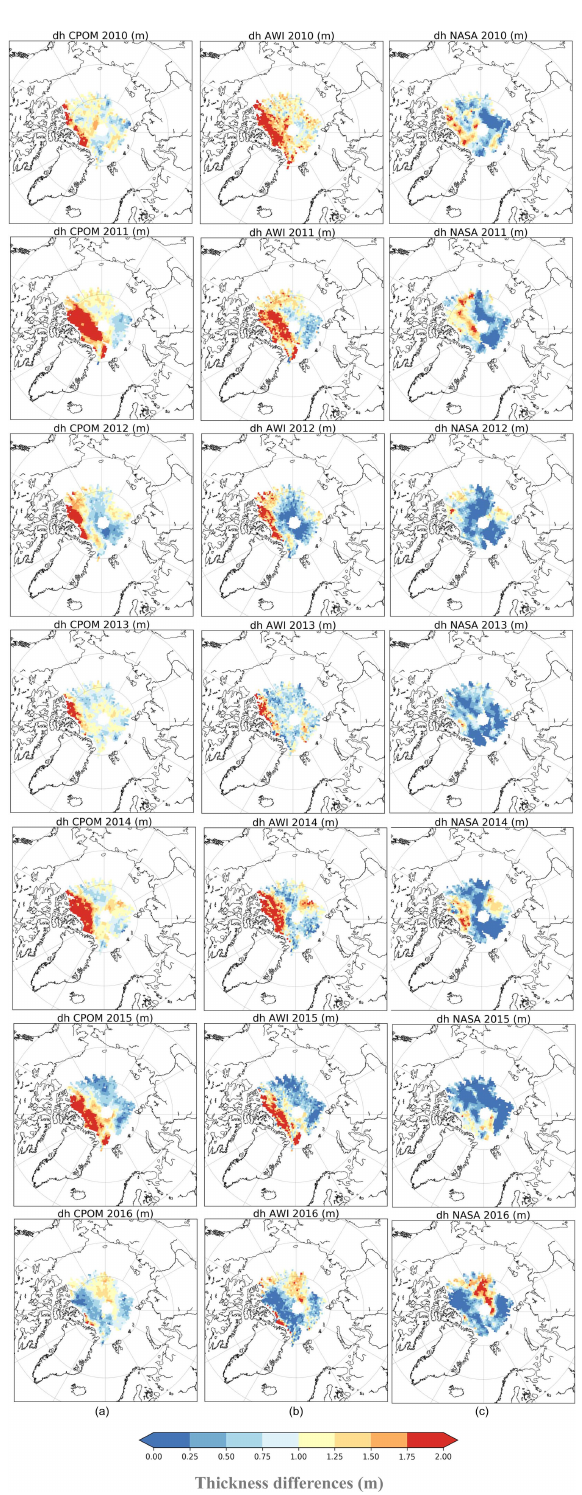
Figure 11. Comparison between ice growth (April minus November) in the UCL CPOM CryoSat-2 thickness retrievals (a) and those from the Alfred Wegener Institute (AWI) (b) and NASA (c) . The year shown corresponds to the November months, such that 2016 refers to ice thickness differences between April 2017 and November 2016. Results are only shown for the area shown in Fig. 1c, which represents grid points that had more than 100 individual measurements and a mean sea ice thickness greater than 0.5m during the November months.